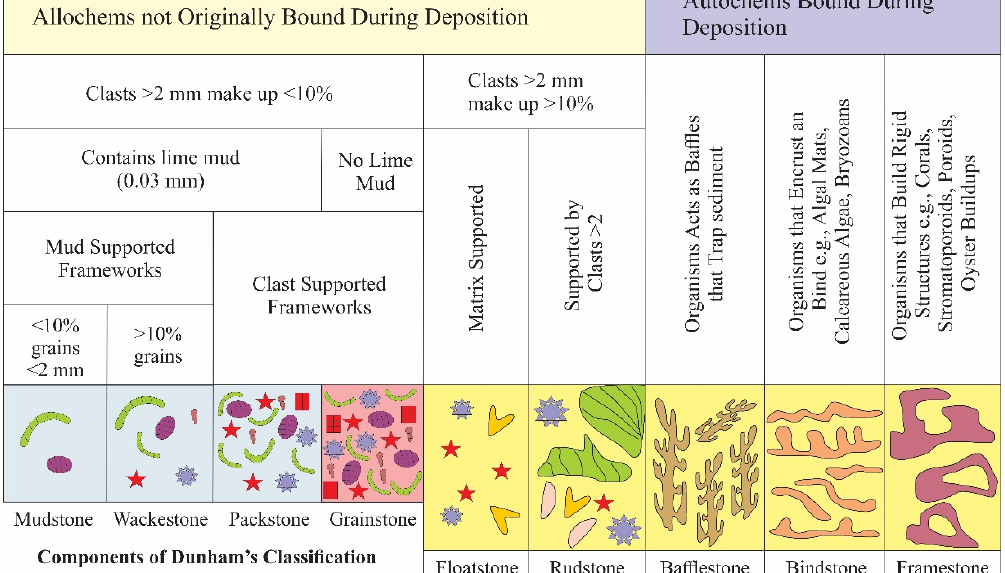
Figure 3. Representing the Dunham classification of limestone based on depositional texture.